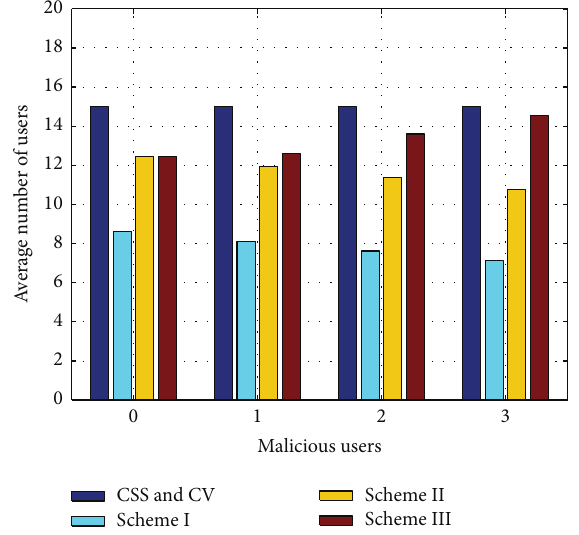
Figure 9: Average number of users for global decision in conven- tional CSS, CV (Chair-Varshney), and our proposed schemes for numbers 0, 1, 2, and 3 of malicious